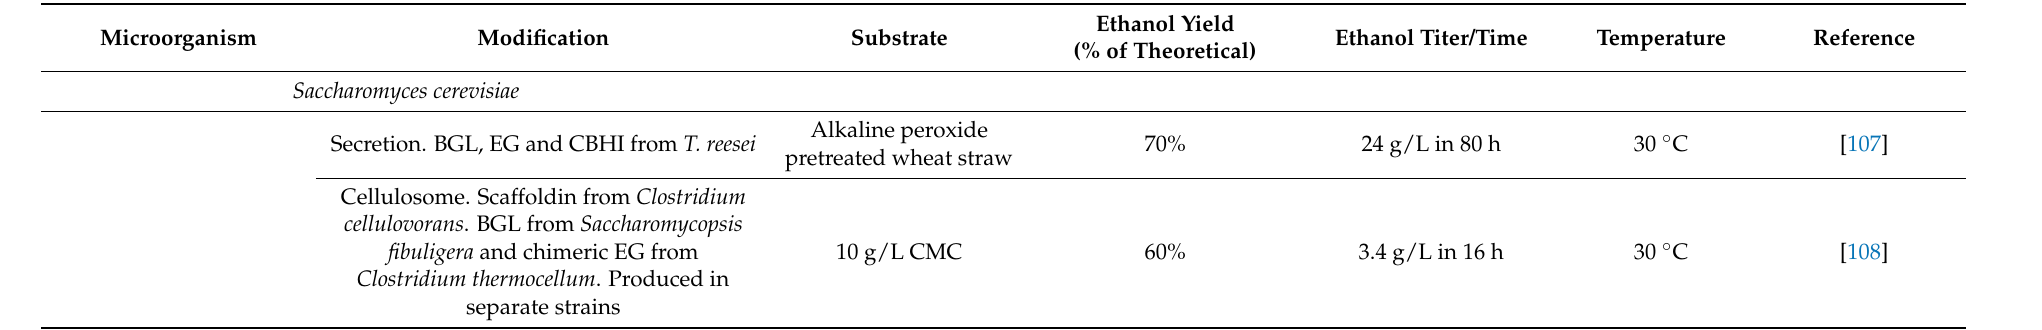
Table 2. Different strategies and outcomes of modified ethanologenic microorganisms for consolidated bioprocessing. Ethanol yield was calculated (when data was available) as the ratio of grams of ethanol produced by the total of potential fermentable sugars in the medium and presented as percentage of the theoretical yield 0.511 g/g. N.D.: not determined/described. β -glucosidase (BGL), endoglucanase (EG), cellobiohydrolase I (CBHI), cellobiohydrolase II (CBHII), β -xylosidase (XylA); xylanase (Xyn) LPMO: lytic polysaccharide monooxygenases. CDH: cellobiose dehydrogenase. CMC: carboxymethyl cellulose. PASC: phosphoric acid swollen